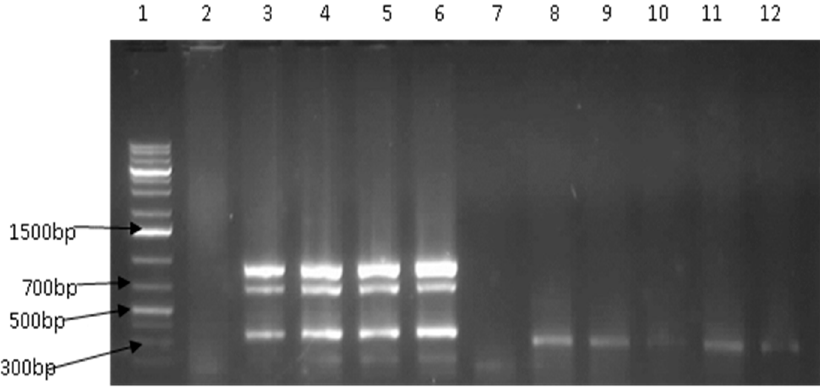
Figure 4. Representative gel of multiplex PCR detected V. fluvialis virulence genes. Lane 1: molecular weight marker (1 kb plus), lane 2: negative control, lane 3: positive control, lanes 4–6, 8, 9, 11 and 12: positive for stn (375 bp), lanes 4–6: positive for vfh (800 bp), lanes 4–6: positive for hupO and lanes 7 and 10: negative isolates.